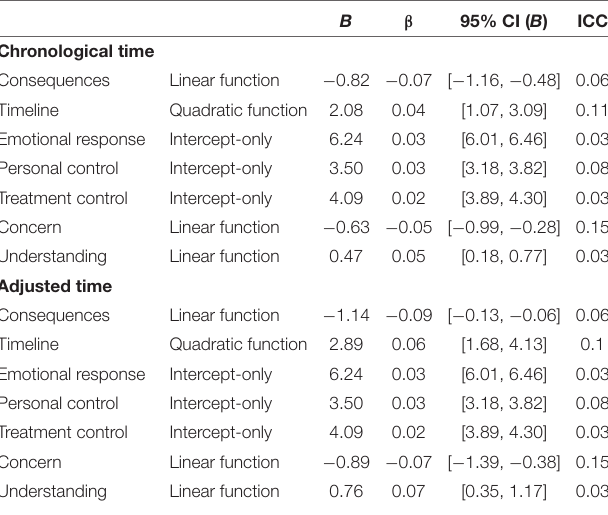
TABLE 4 | Estimates for intercept-only models and effects of time on illness